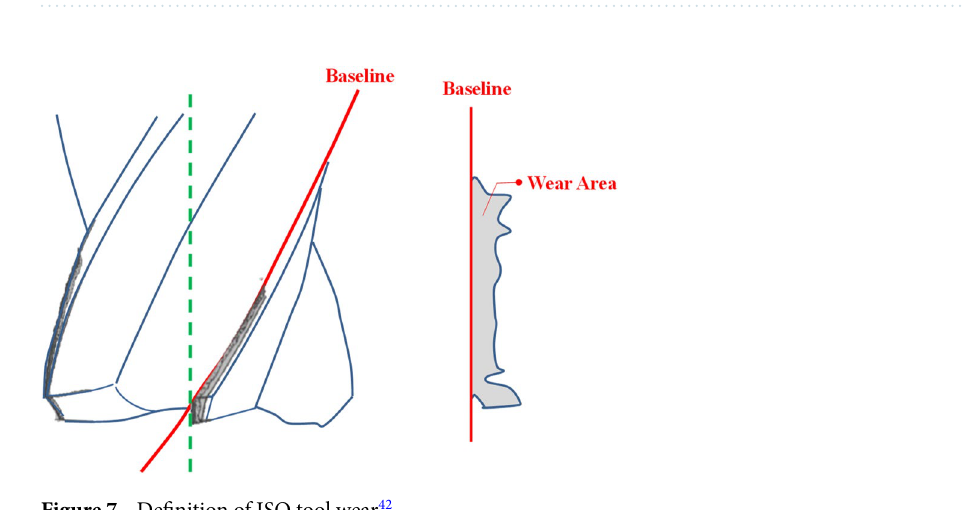
Table 3. The detection results of the cutting tip with the indicators of precision, recall and F1 score.